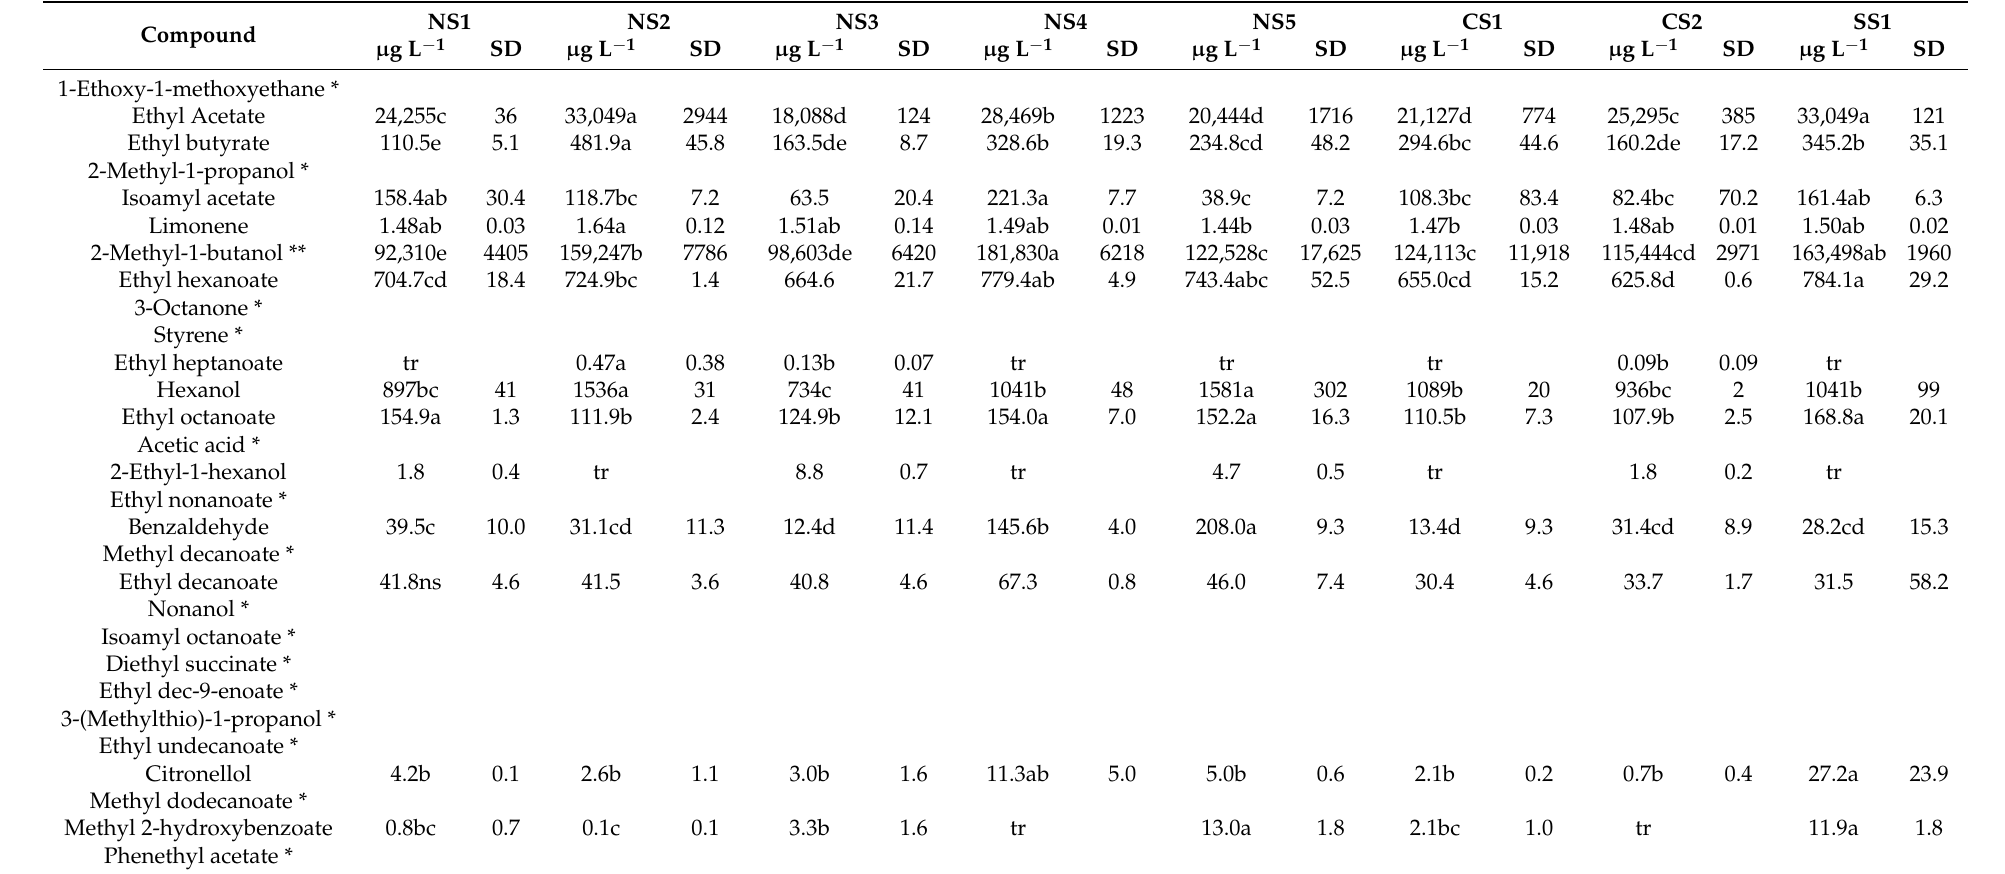
Table 5. Concentration of the main volatile organic compounds in Cannonau wines from the different